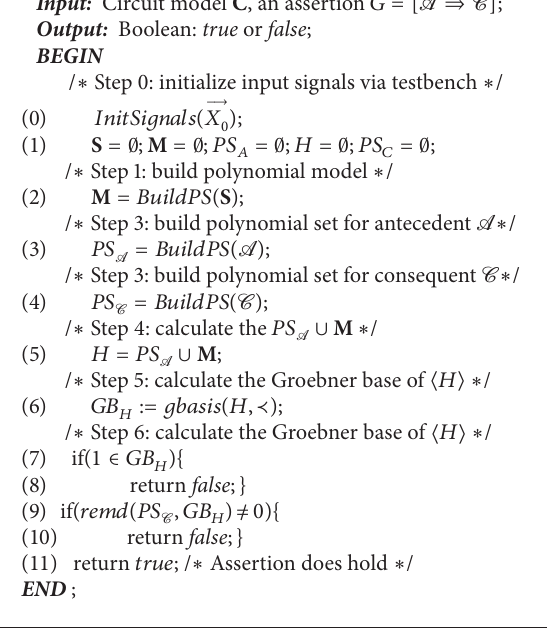
Algorithm 1: Assertion checking: 𝐴𝑠𝑠𝐶ℎ𝑘( C , 𝐺)